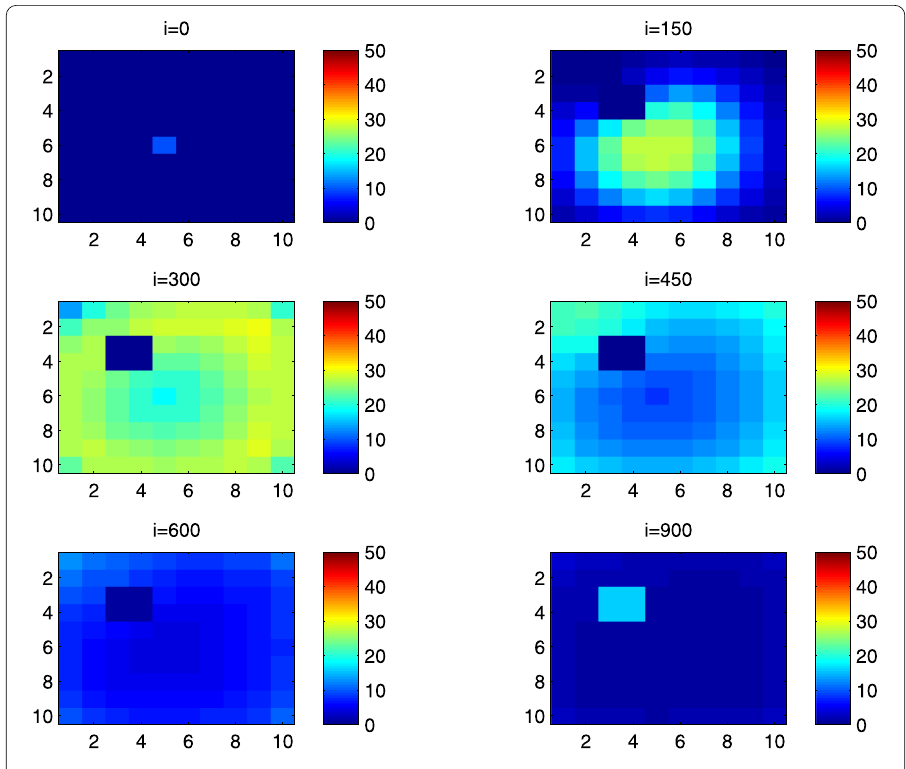
Figure 11 I Cpq behavior in the presence of optimal controls (11). The case when the disease starts from the center of (cid:2)